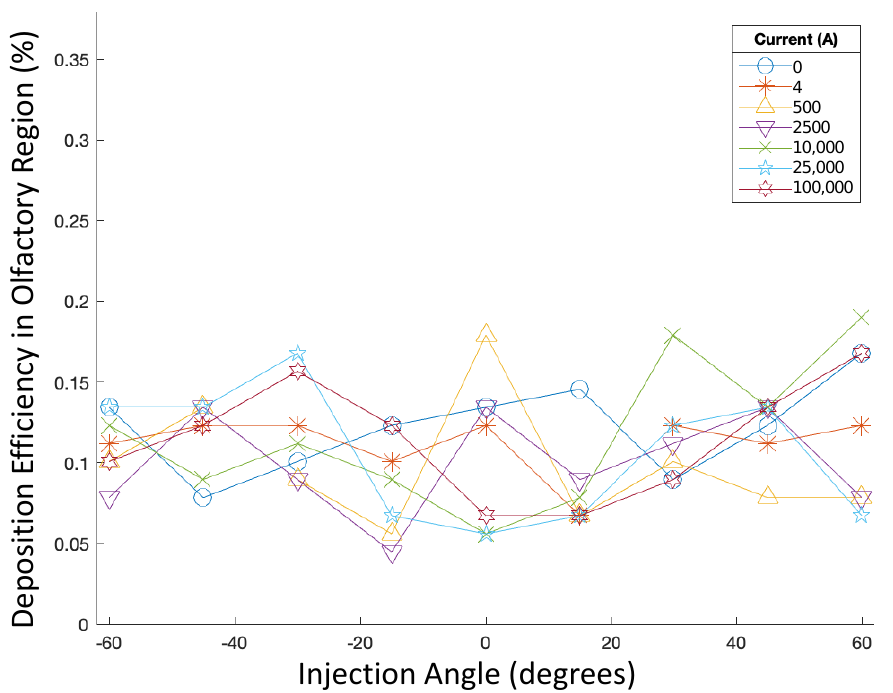
Figure 6. Deposition efficiencies in varying magnetic fields for varying injection